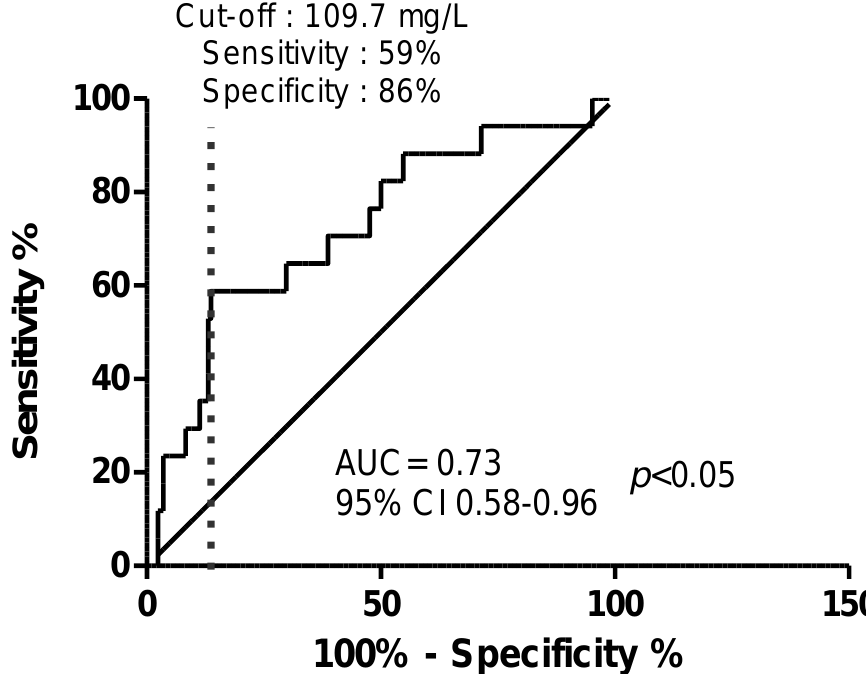
Figure 3. Receiver-operating characteristic curve of amoxicillin plasma concentration in relation to its attributable neurotoxicity or not. AUC: area under the curve; 95% CI, 95%: confidence interval.